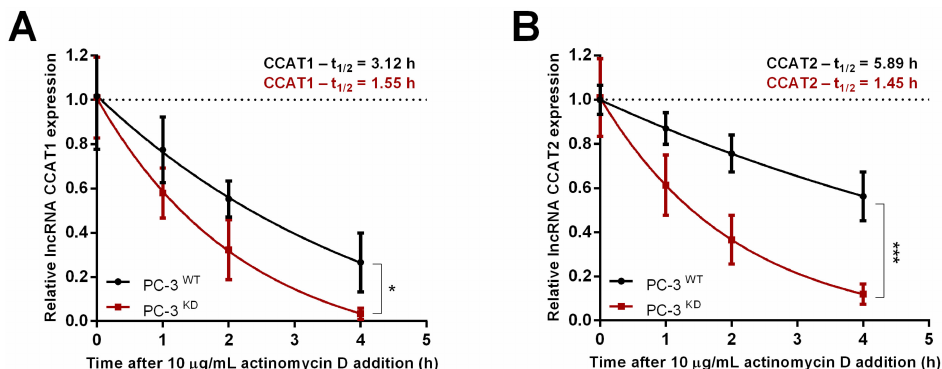
Figure 6. m 6 A stabilizes CCAT1 and CCAT2 lncRNAs. VIRMA knockdown decreases the stability of lncRNA CCAT1 ( A ) and CCAT2 ( B ) in PC-3 cells upon treatment with Actinomycin D, * p < 0.05 and *** p < 0.0001, Sum of squares F test.